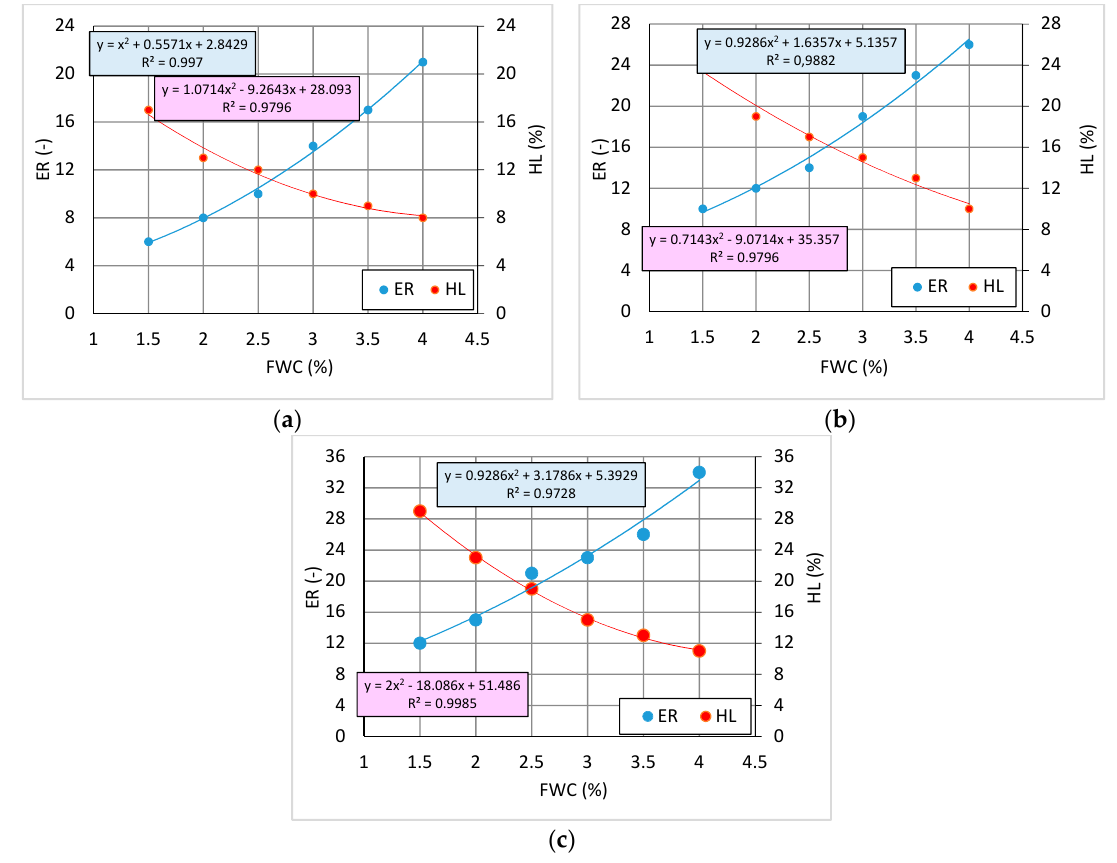
Figure 7. Foaming characteristics of bitumen 50/70 + 0.2% SAA ( a ), 50/70 + 0.4% SAA ( b ), 50/70 + 0.6% SAA ( c ). Materials 2019 , 12 , x FOR PEER REVIEW